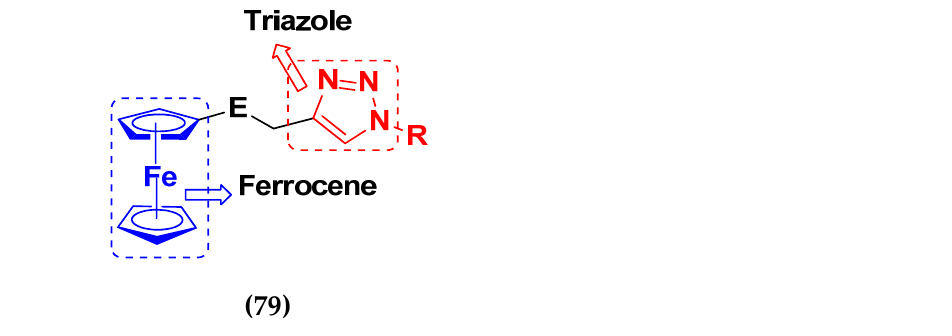
Figure 76. Structure of ferrocene-chalcogeno (sugar) triazole conjugate derivatives ( 79 ). Table 65. In vitro cytotoxic activities of ferrocene ‐ chalcogeno (sugar) triazole conjugate compounds 79 ( a – d ).